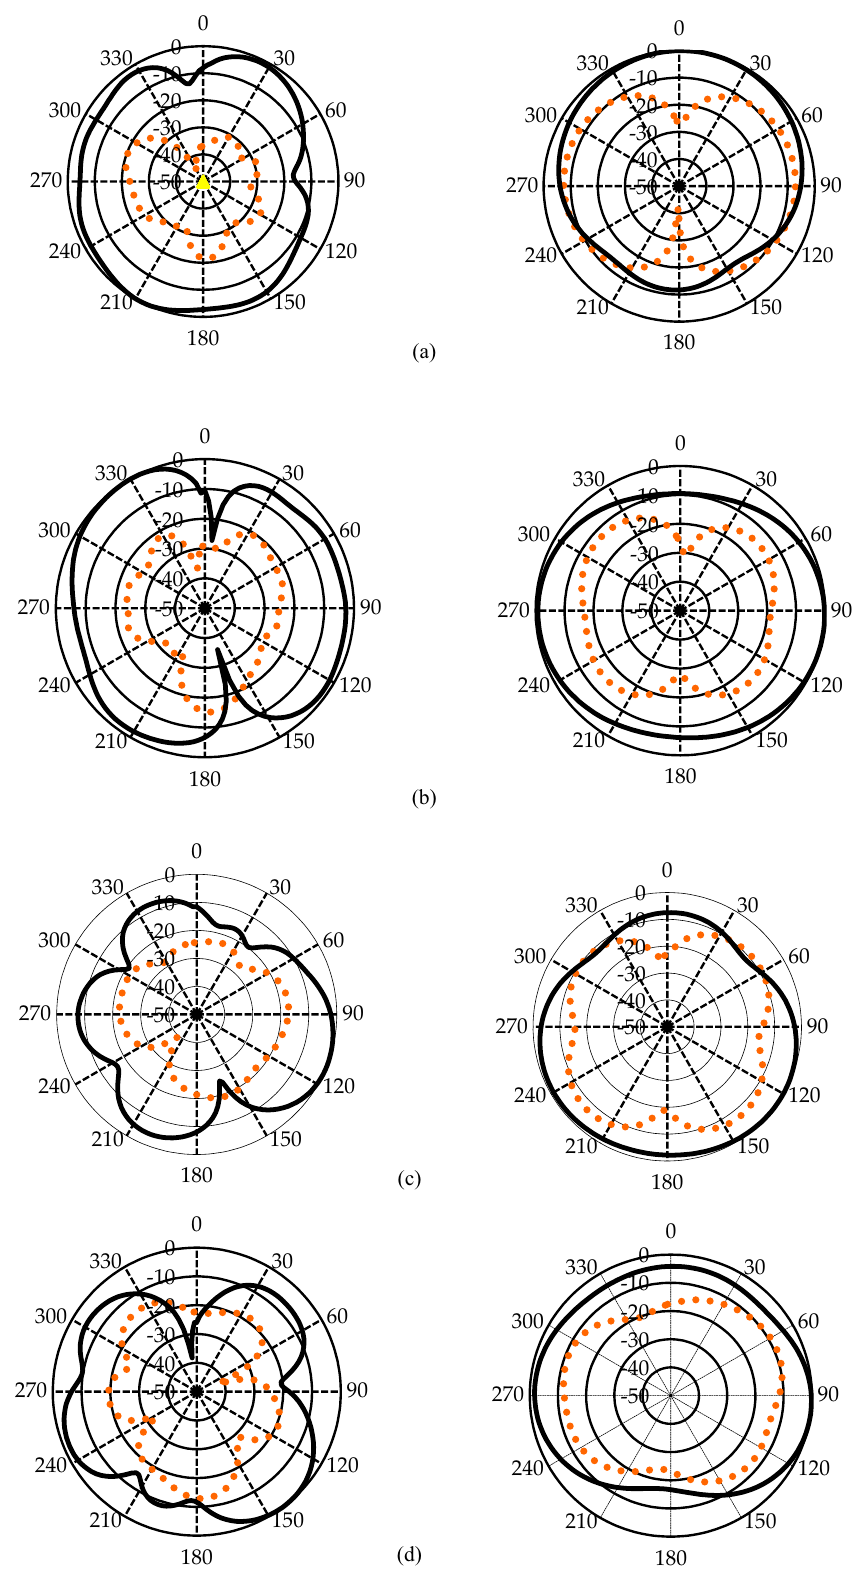
Figure 9. Measured radiation pattern at ( a ) 3.375 GHz, ( b ) 5.90 GHz, ( c ) 7.98 GHz, and ( d ) 10.1